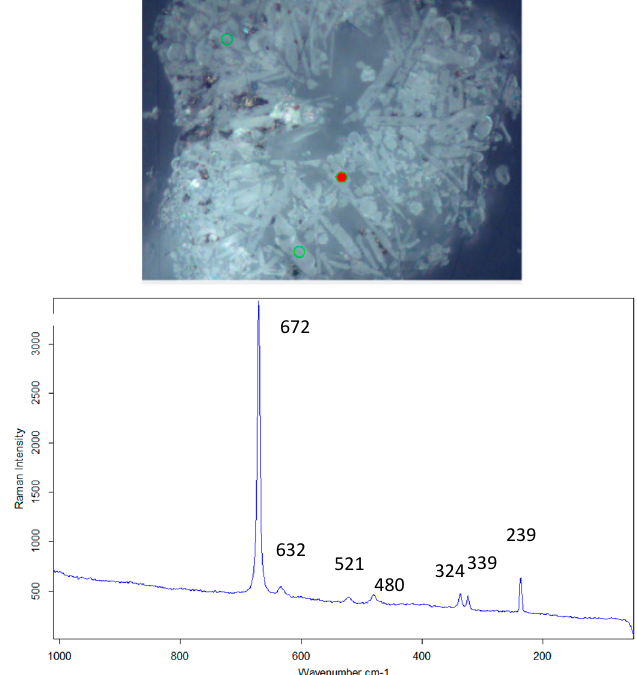
Figure 5. Raman spectrum acquired on rosary-shaped aggregates (SSV_B1 blue sample from the monastery of San Severo in Classe, Ravenna, Italy—unpublished data), with bands at 632 and 480 cm -1 demonstrating that they are made of cubic Ca 2 Sb 2 O 7 [15].